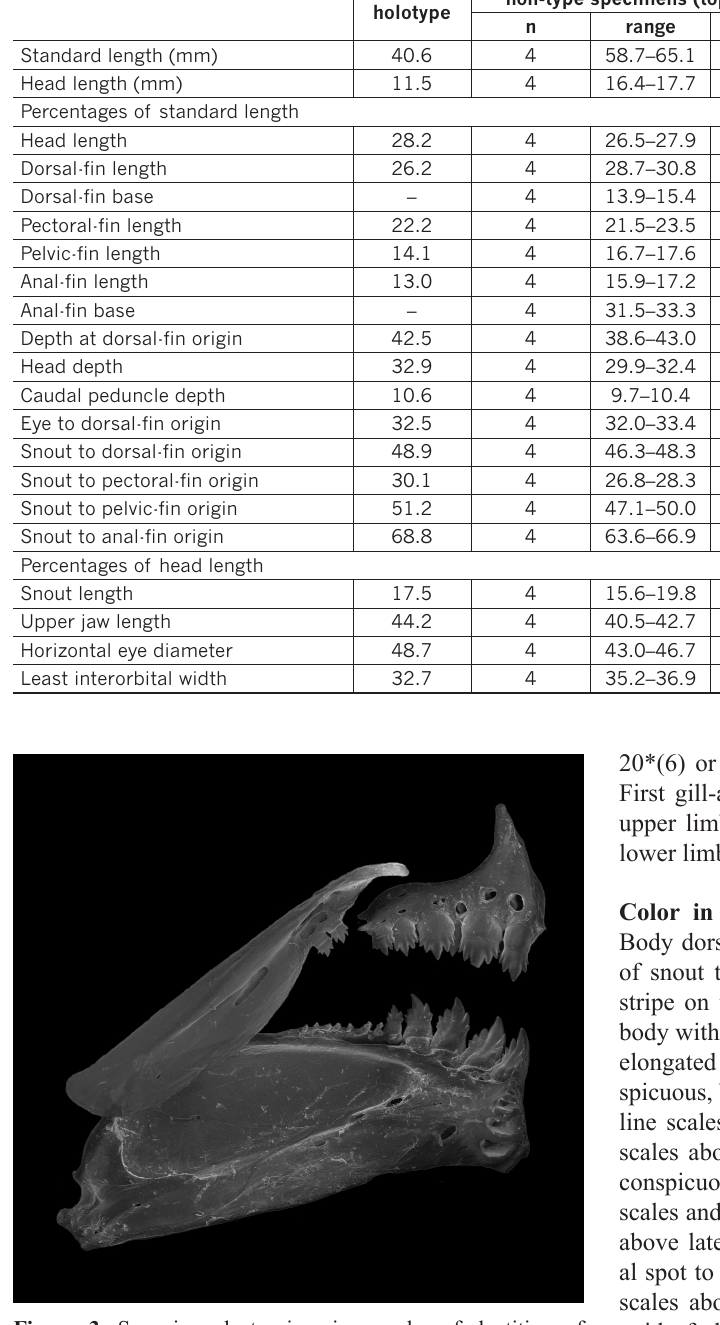
Figure 3. Scanning electronic micrography of dentition of Moenkhausia megalops , INPA 40617, 43.2 mm SL, left inter- nal lateral view of premaxilla, maxilla and dentary bones. Scale bar: